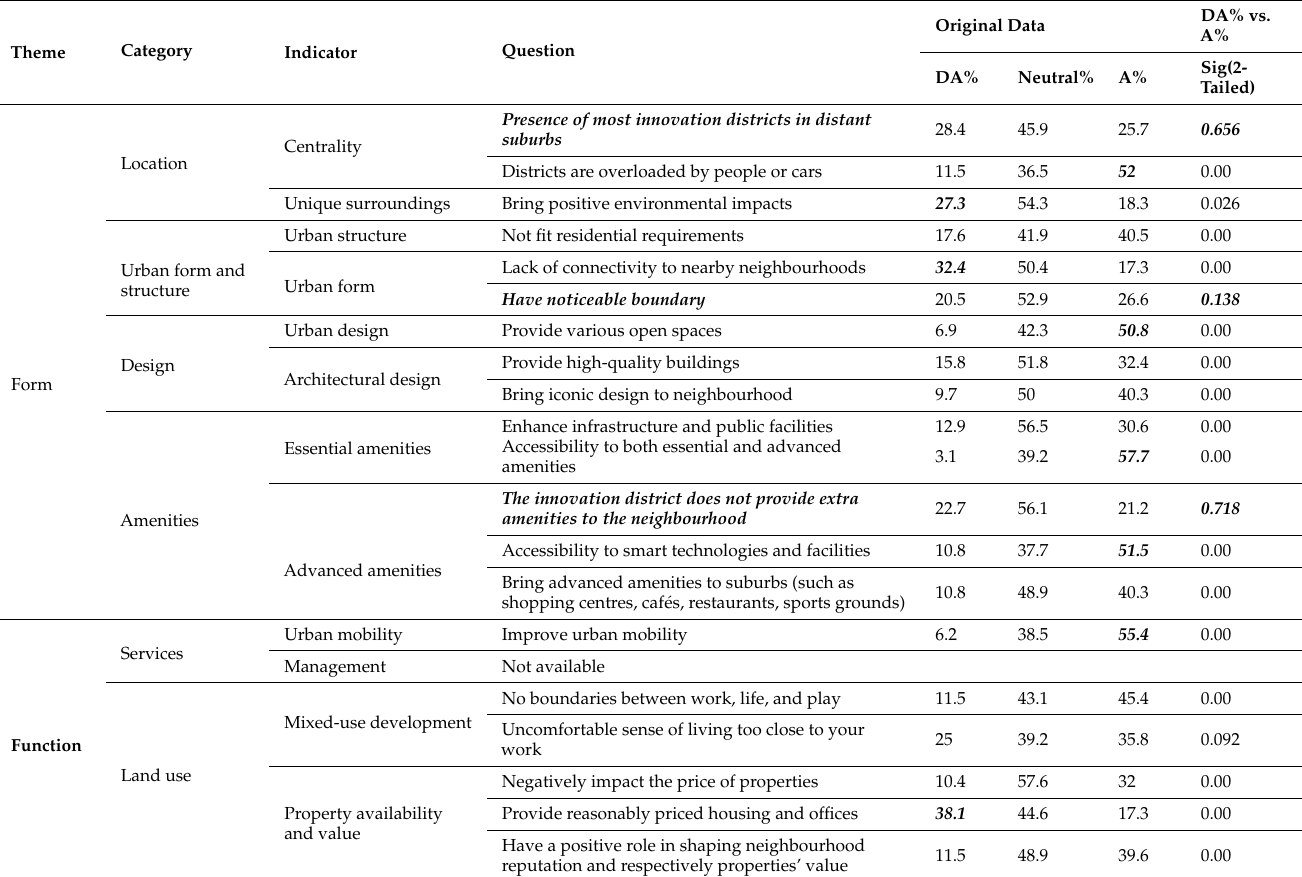
Figure 3. Quantitative evaluation of place characteristics in Brisbane Technology Park. In total, 278 valid Likert-scale questionnaires from the public across Brisbane were initially identi fi ed. Then, 55 questions collected from each participant were classi fi ed